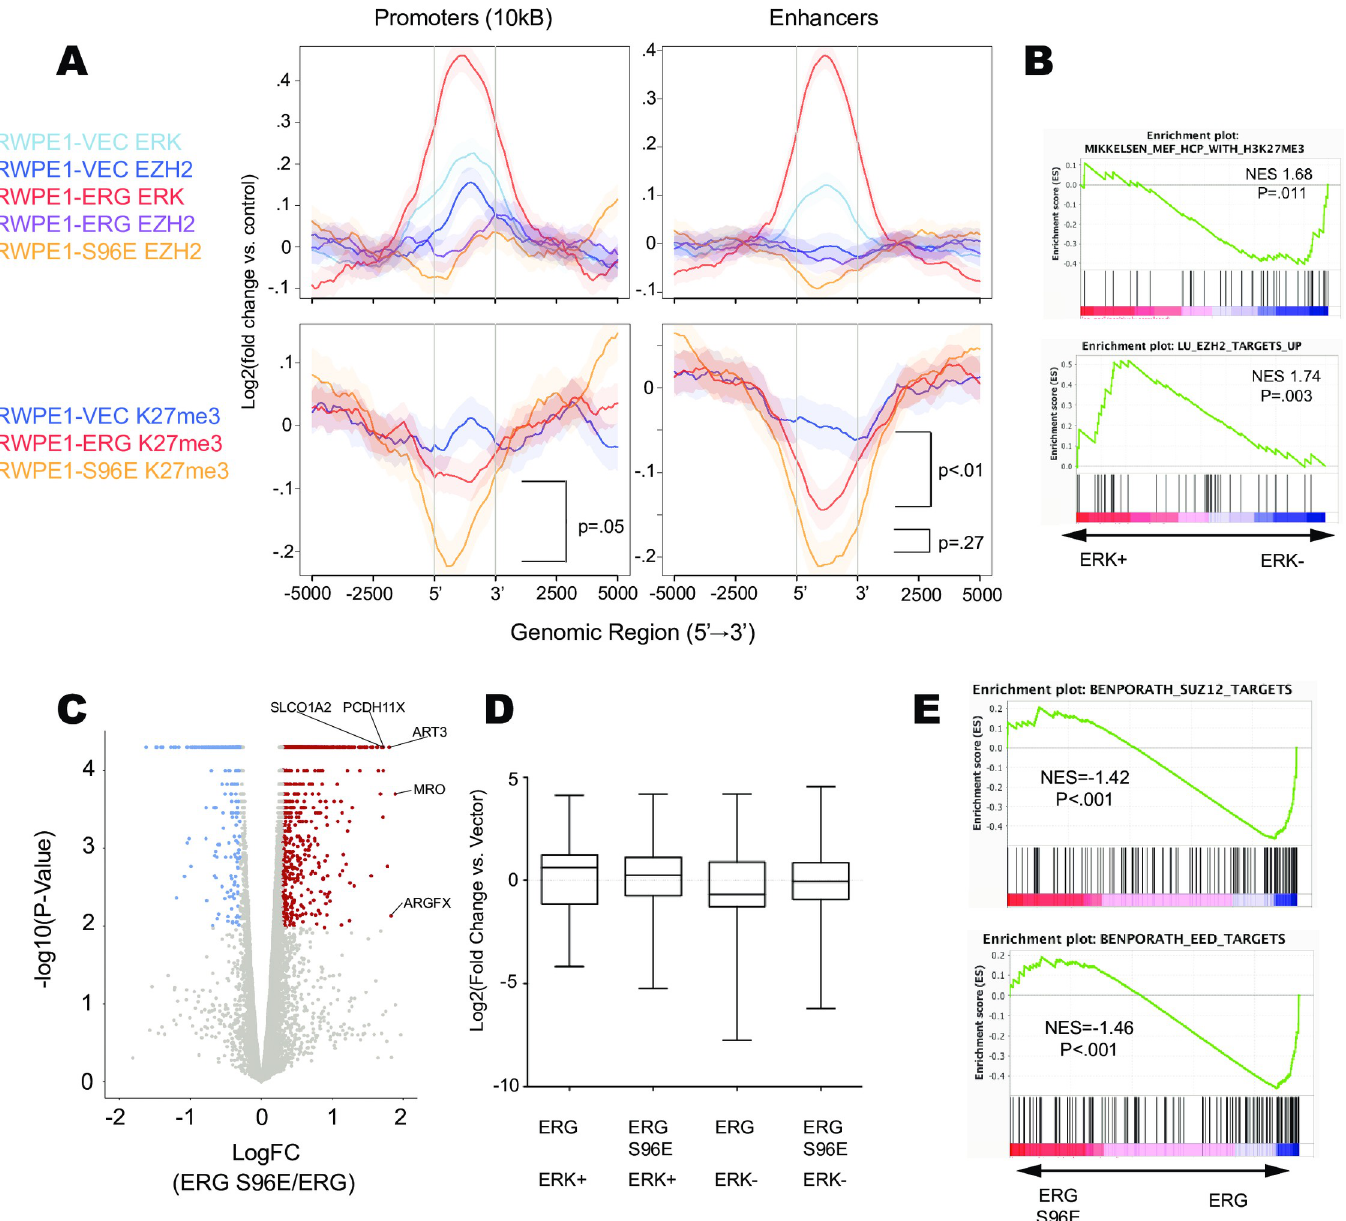
Fig 3. Ras/ERK signaling opposes PRC2 repression at ERG binding sites. (A) Average plots of ERK, EZH2, and H3K27me3 ChIP-Seq conducted in RWPE1, RWPE1-ERG, or RWPE1-ERG S96E cell lines centered on ERG bound regions in RWPE1 cells [15] (B) GSEA analysis of ERK ChIP signal ranked across ERG bound regions in RWPE1 cells. (C) Volcano plot showing differentially regulated genes determined by RNA-Seq between RWPE1 cell lines expressing ERG S96E and ERG (red— significantly activated / blue significantly repressed). (D) Log2(Fold change vs. Vector) of genes nearest ERG-alone or ERG/ERK co-bound regions in RWPE1 cells expressing ERG or ERG S96E. (E) GSEA analysis of differentially regulated genes called by RNA-Seq comparing RWPE1 ERG S96E to RWPE1